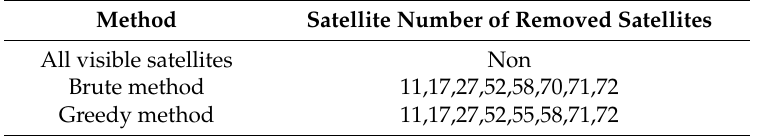
Table 8. Satellites removed from the optimal satellite subset by the greedy and brute methods.